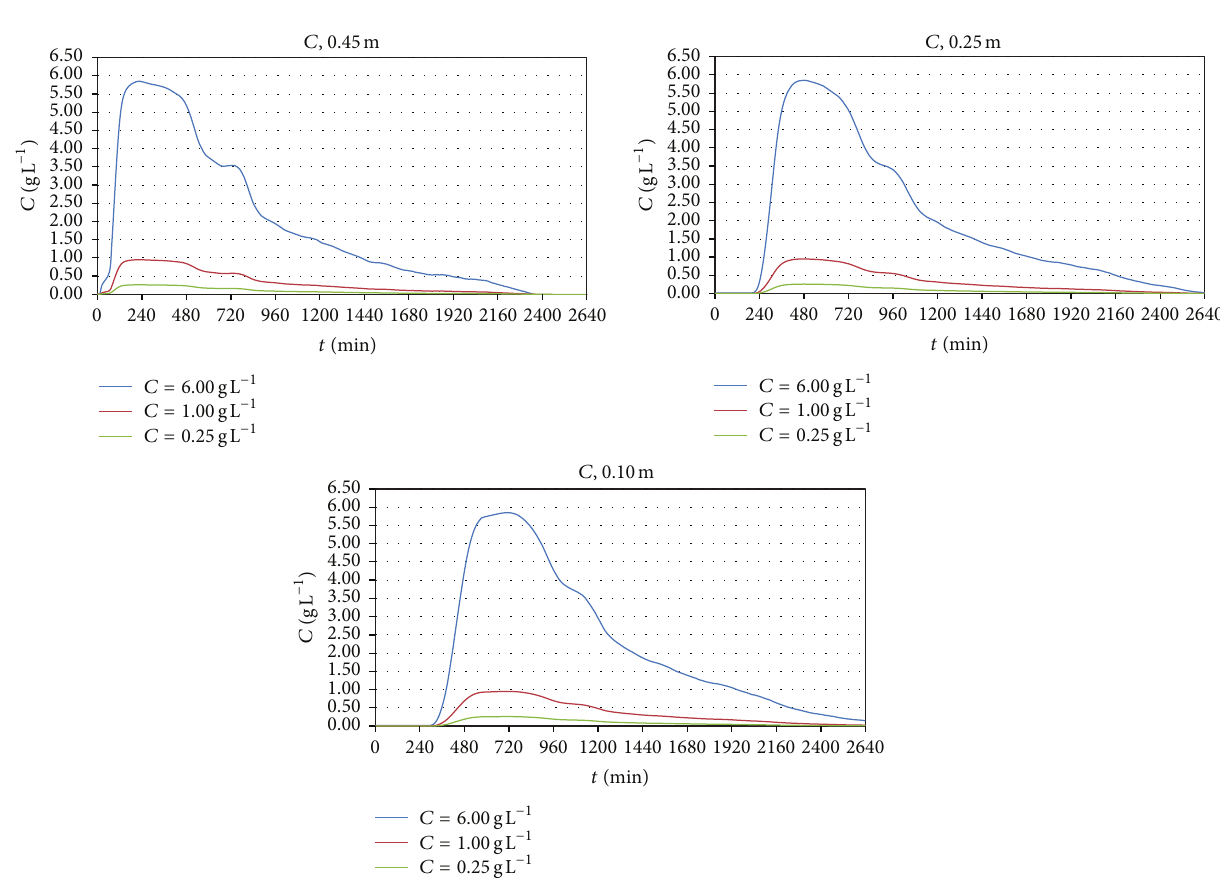
firstly converting electrical potential values (mV) into con- centration values (g L −1 ) by the Planck-Henderson equation and then calculating the transport parameters by the equa- tions implemented in the COMSOL Multiphysics environ-